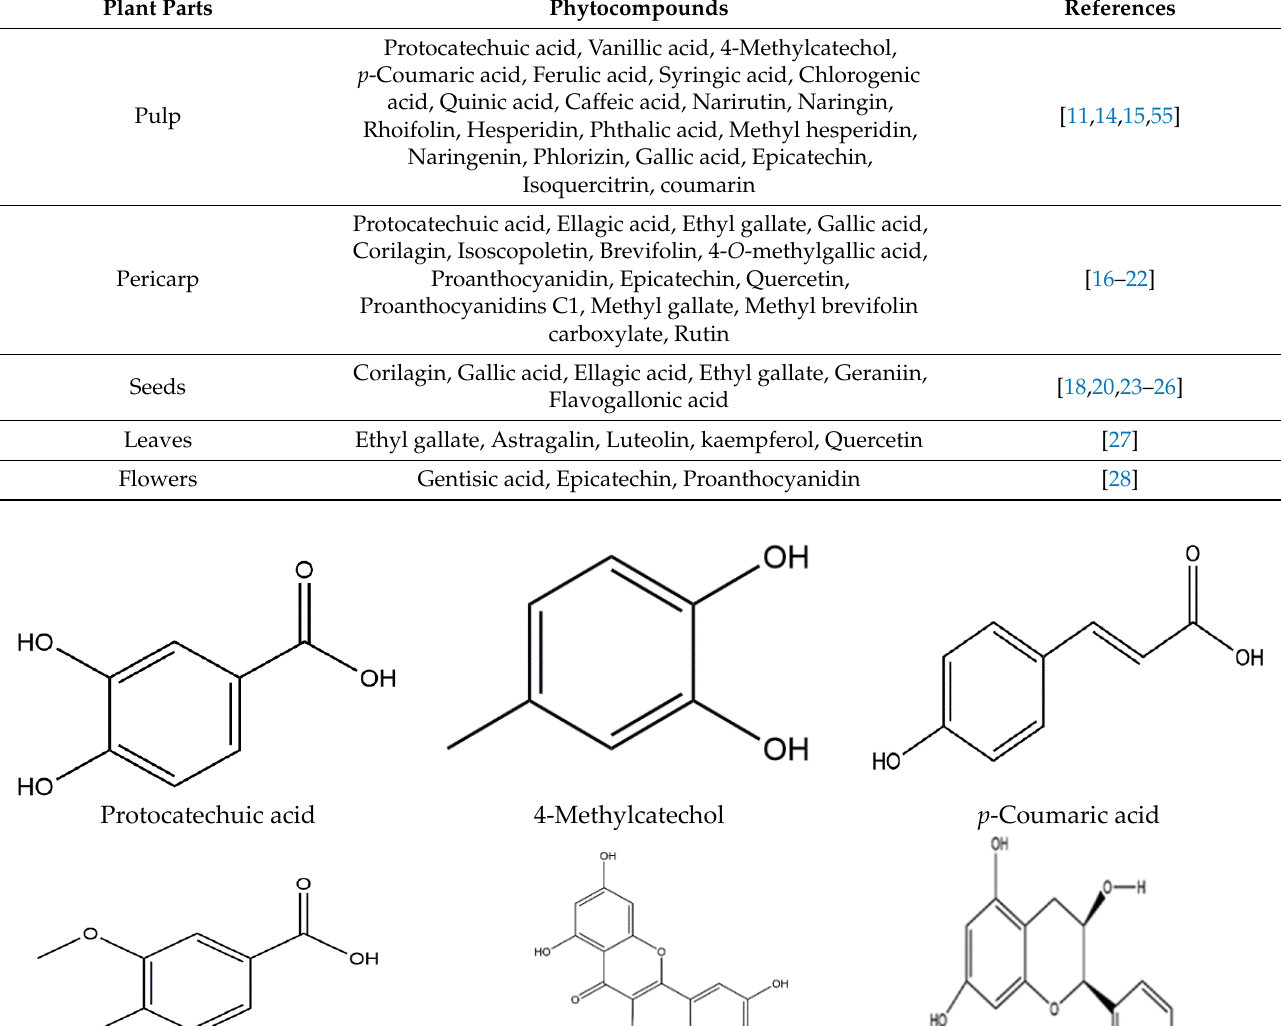
Table 3. Tabular representation of extracted bioactive phytochemicals from the different parts of the D. longan Lour plant. Plant Parts Phytocompounds